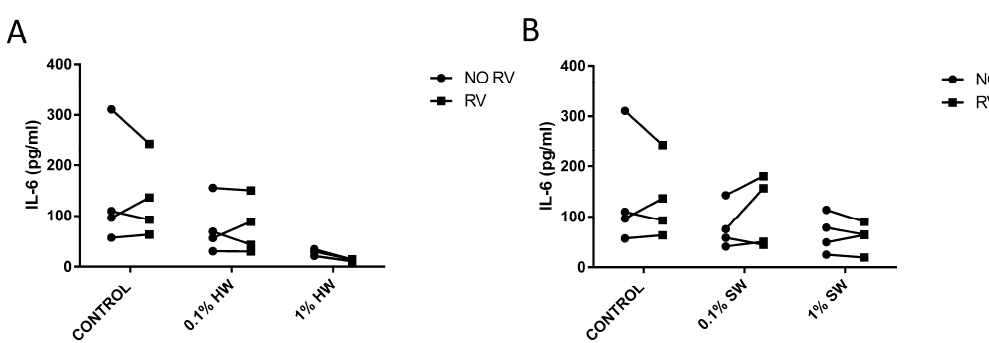
Figure 5. Measurement of IL-6 production from hardwood ( A ) and softwood ( B ) smoke exposure and RV-16 infection. Primary human lung fibroblasts ( n = 4) were stimulated with hardwood and softwood smoke extract at 0.1% and 1% concentration alone, RV-16 infection alone (MOI = 1), or both and incubated for 24 h. Unstimulated fibroblasts were also measured for IL-6 constitutive release. Supernatants were collected for IL-6 concentration via ELISA. Data expressed as pg/mL. Statistical analysis was executed using two-way ANOVA with Sidak’s post-test.